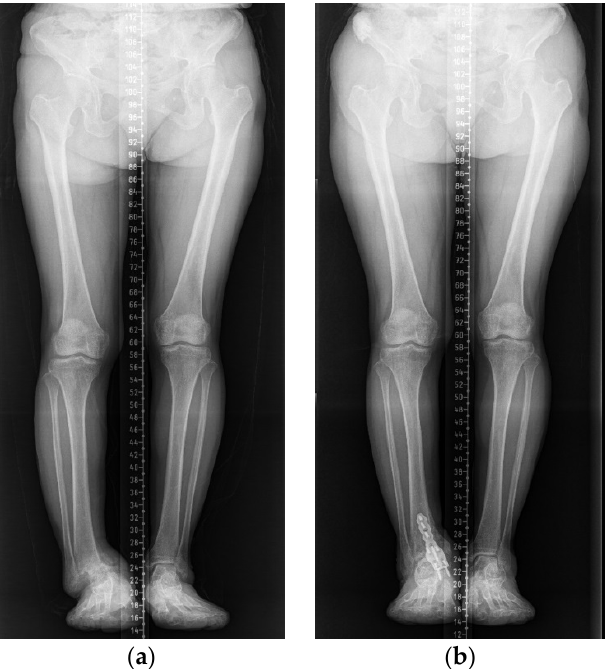
Figure 9. Scanograms showing leg length discrepancy correction from 3 cm before surgery ( a ) to 1 cm after surgery ( b ).